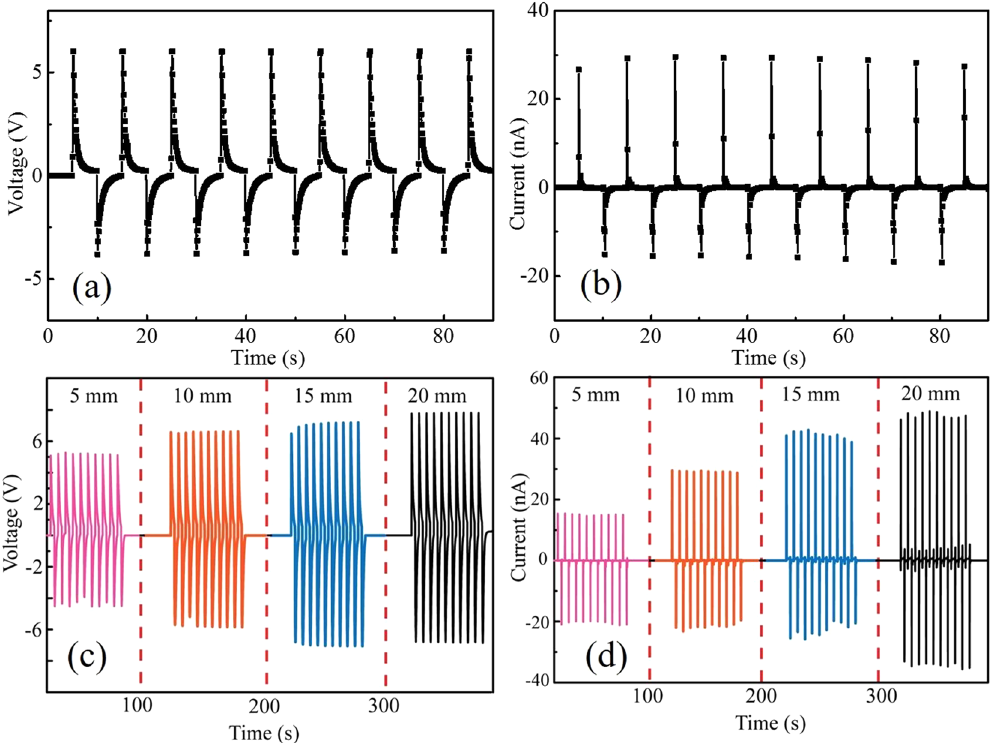
20 mm). ( c ) and ( d ) Show the output voltages and currents generated by a BTO-PVDF generator (20 wt.% BTO in the BTO-PVDF composite) when subjected to a 10 mm bending